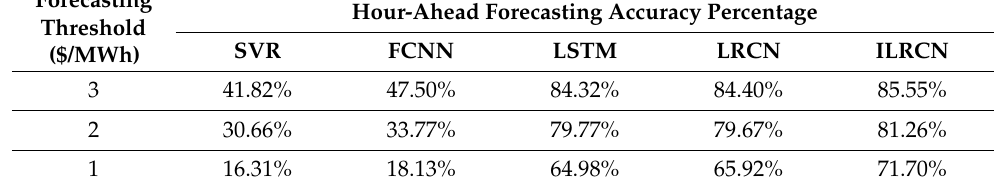
Table 2. Accuracy percentage comparison between FCNN model, LSTM model, LRCN model, and the proposed ILRCN model for hour-ahead forecasting.